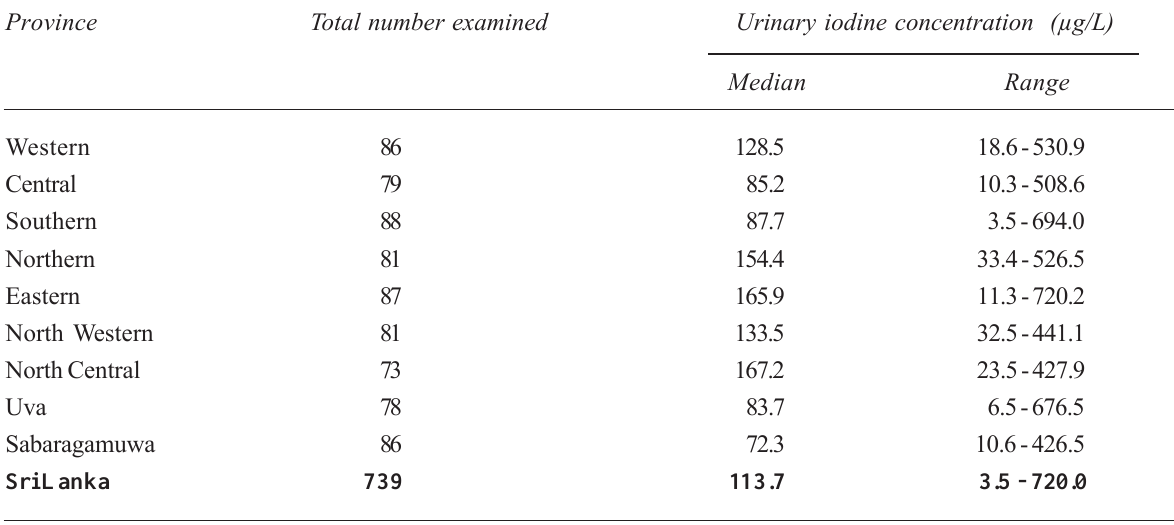
Table 1. Urinary iodine levels of pregnant women by provinces